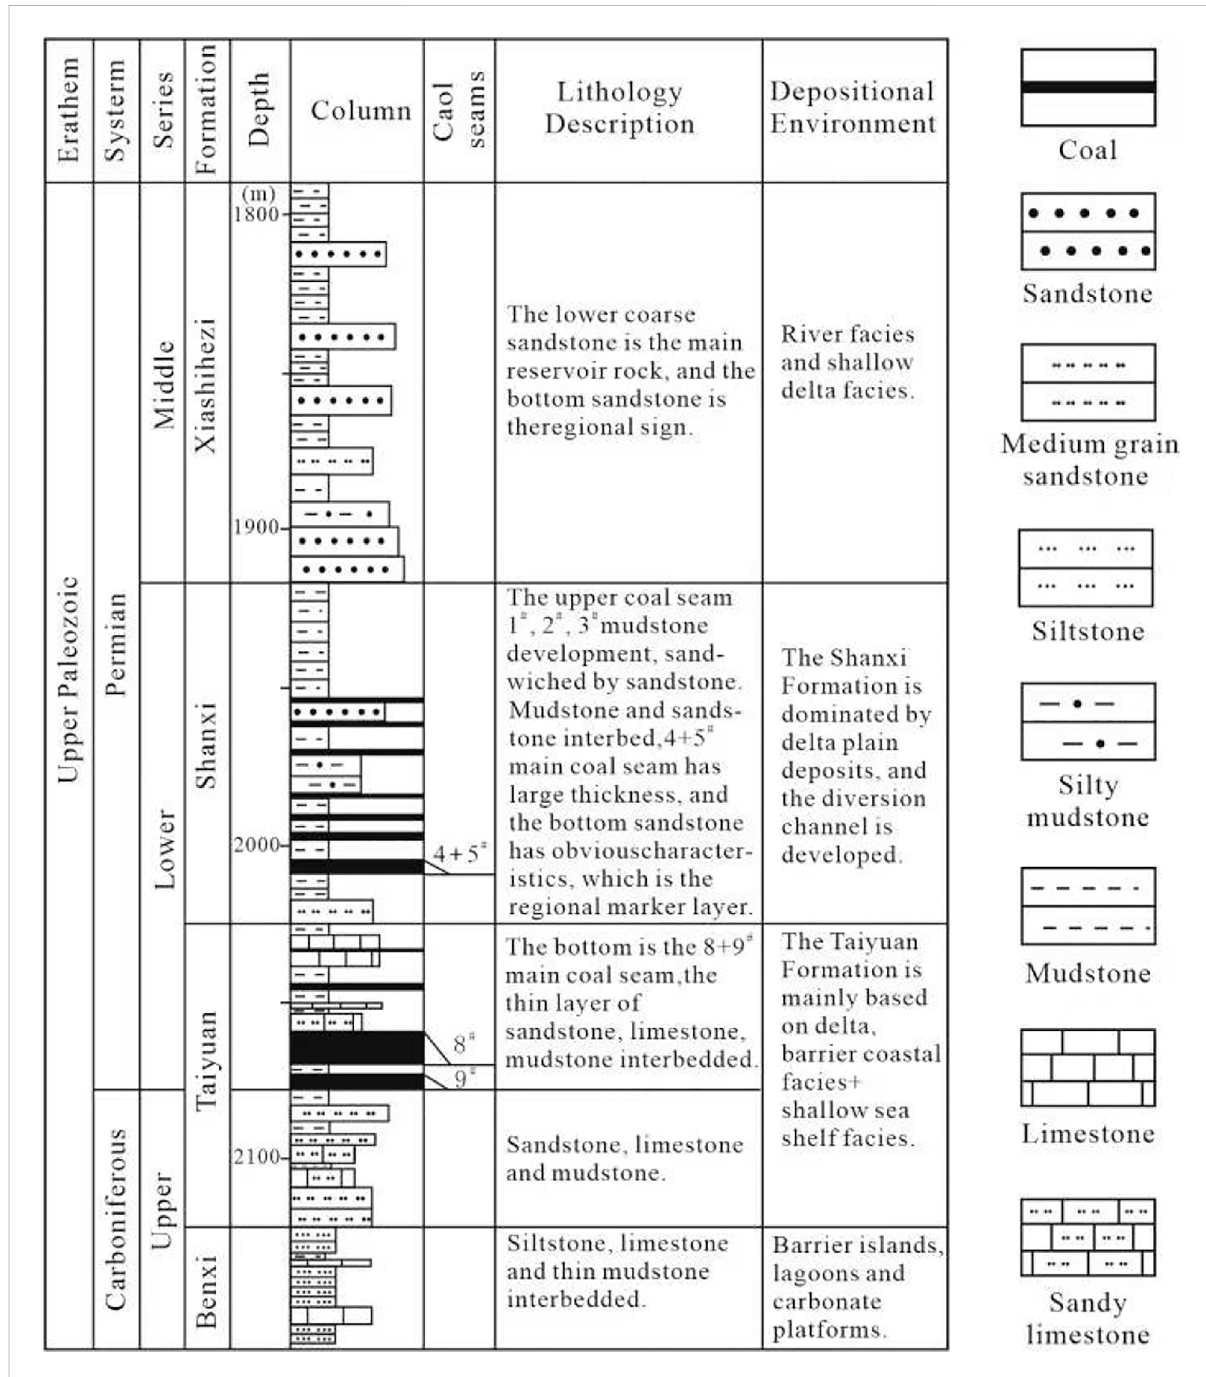
FIGURE 2 Stratigraphic column of coal measures (Li et al., 2017b; Shao et al., 2018) in Linxing